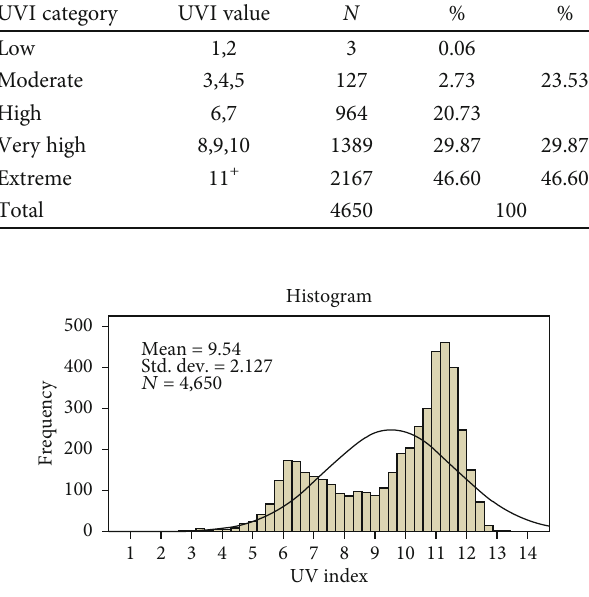
Figure 2: Histogram with normal distribution of daily UVI on the campus of KAU during the study